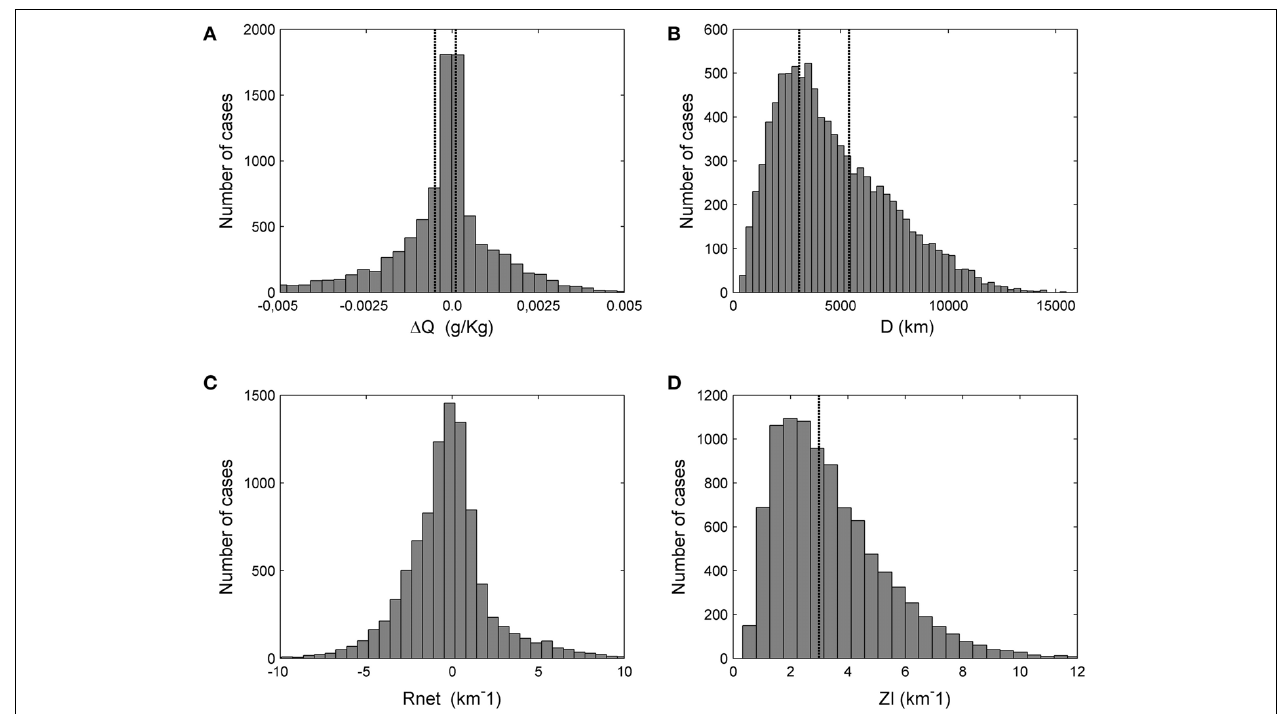
FIGURE 4 | Histograms distribution for: (A) integrated changes in specific humidity (Q), (B) distance “traveled” by the particle (D); (C) integrated value of the curvature (R net ) and (D)